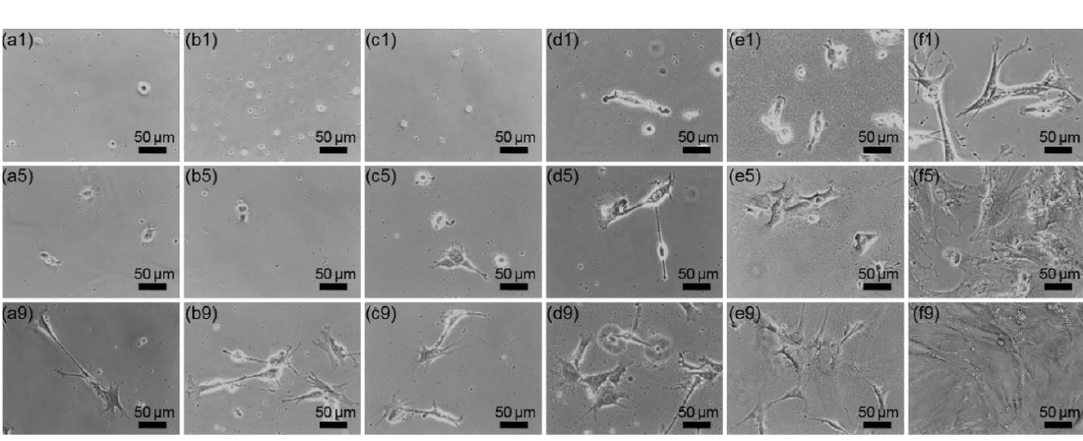
Figure 3. Morphology of rMDSCs on SN at 1, 5, and 9 d. ( a ) SN-60, ( b ) SN-150, ( c ) SN-300, ( d ) SN-500, ( e ) SN-700, and ( f ) glass. The numbers indicate 1, 5, and 9 d. Magnification, ×200; scale bar = 50 μm.